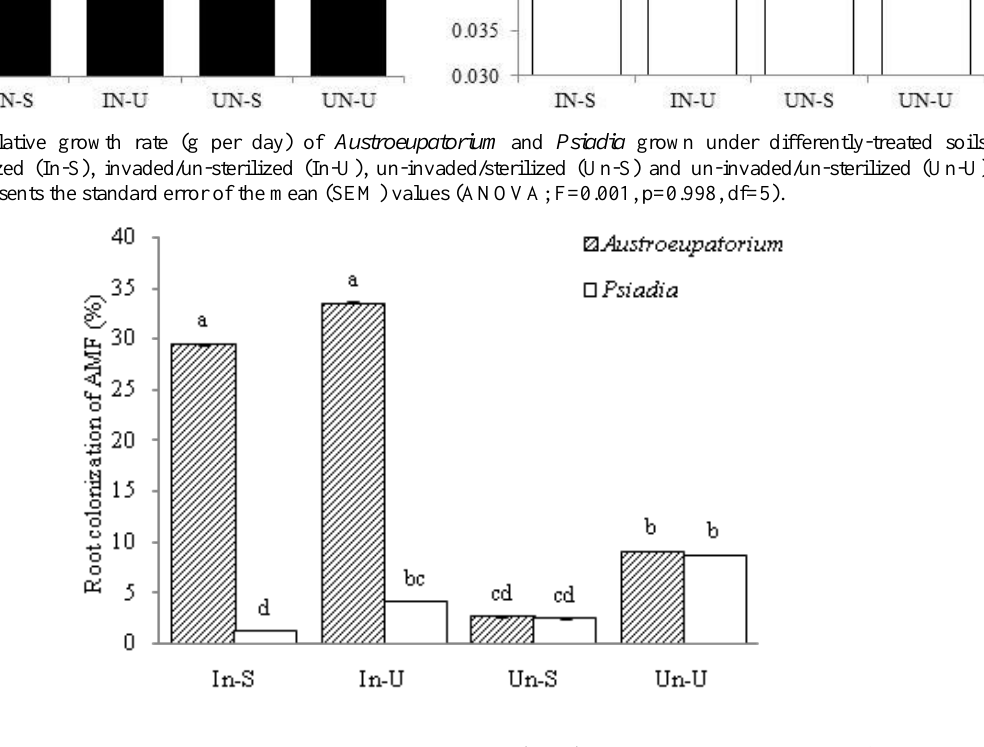
Figure 4: Percentage root colonization of arbuscular mycorrhizal fungi (AMF) in Austroeupatorium and Psiadia grown in differently-treated invaded and un-invaded soils; In-S, In-U, Un-S and Un-U (ANOVA; F=18.66; p≤0.001; df= 5). Vertical bars represent standard error of mean (SEM)